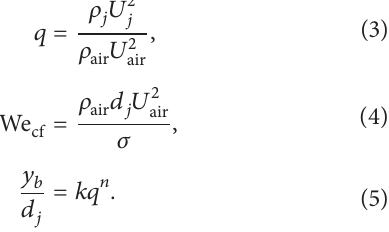
Figure 2: Sketch of